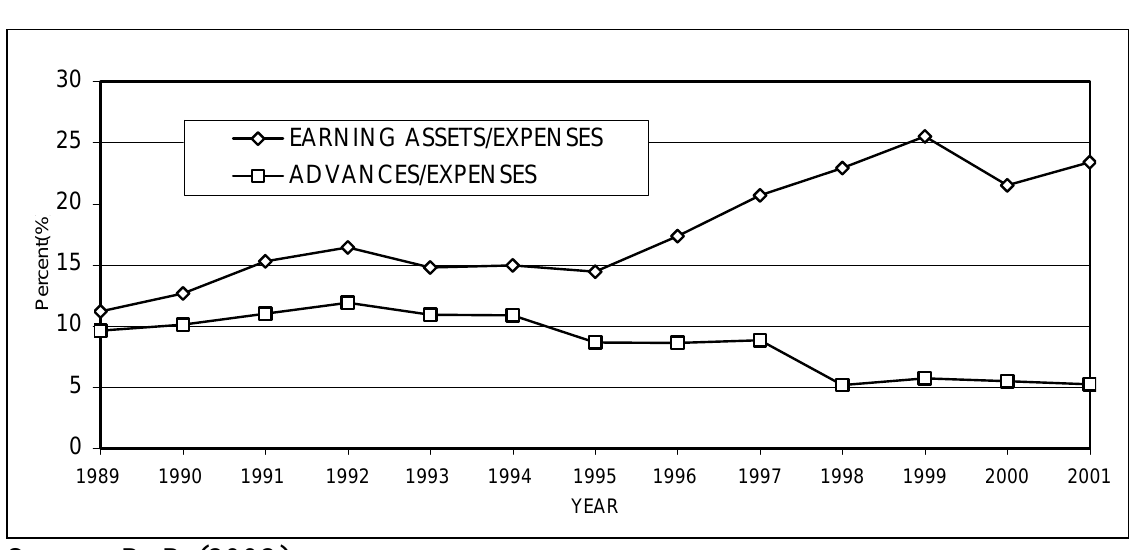
Profitability of Botswana’s banking sector,